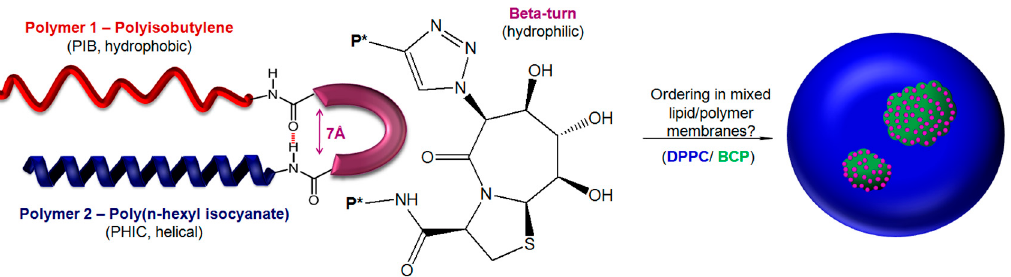
Figure 1. Concept of β -turn mimetic amphiphilic block copolymers and their incorporation into mixed membranes via folded polymer chains. (BCP = block copolymer).